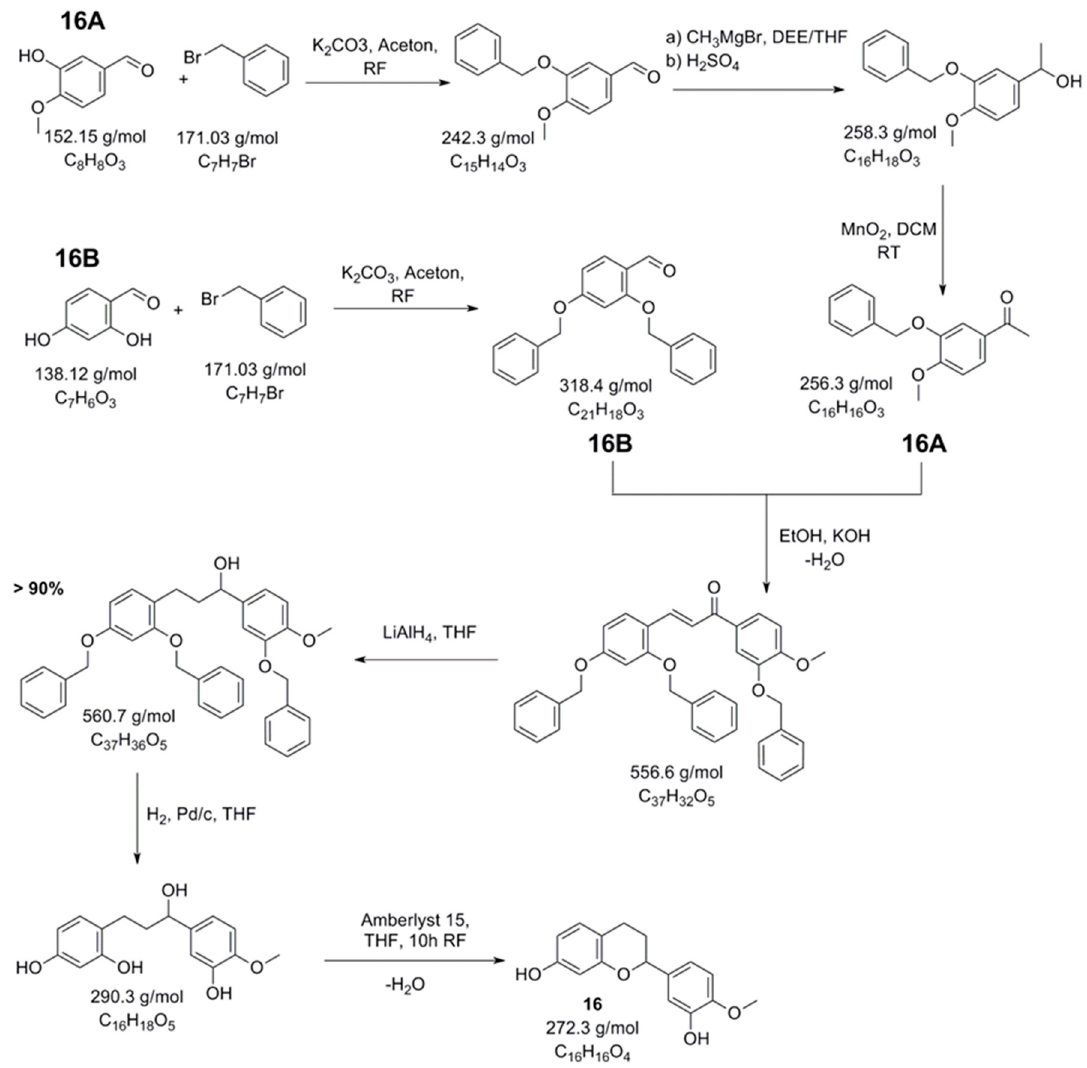
Figure A5. Synthesis of compounds 16A , 16B , and 16 .